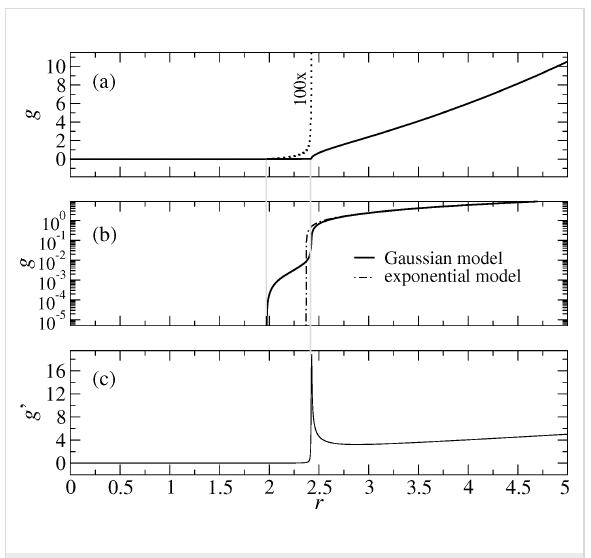
Figure 8: Gap g ( r ) in linear (a) and logarithmic (b) representation as well as (c) first derivative g ′ ( r ) for μ T = 16 in the Gauss model (straight lines). A higher resolution representation of the gap is given in (a) with a dotted line. The exponential model is shown for comparison in (b). The two thin grey lines are drawn where the gap becomes zero (left line) and where the slope of g ( r ) takes its maximum value.